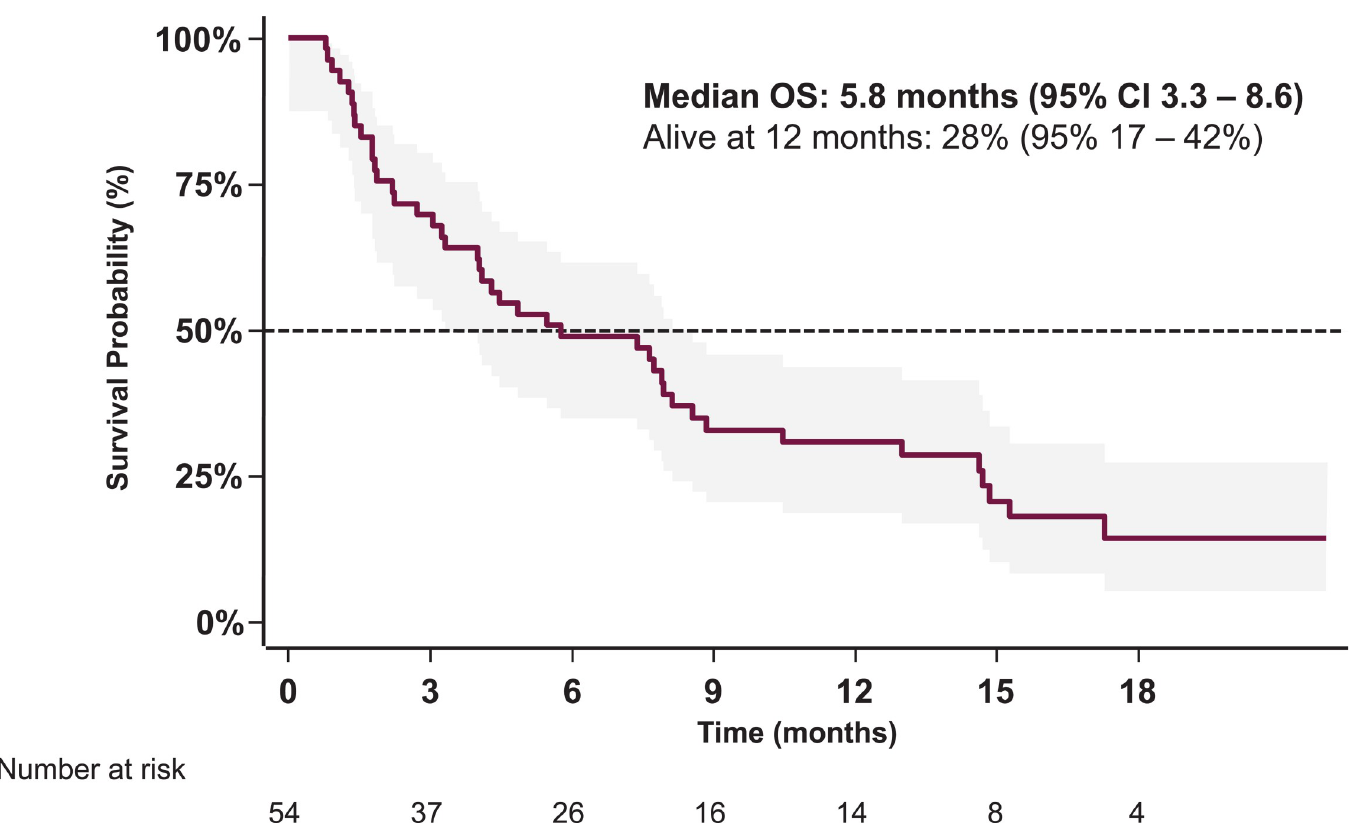
Fig 3. Overall survival (OS) of the study population (with 95%